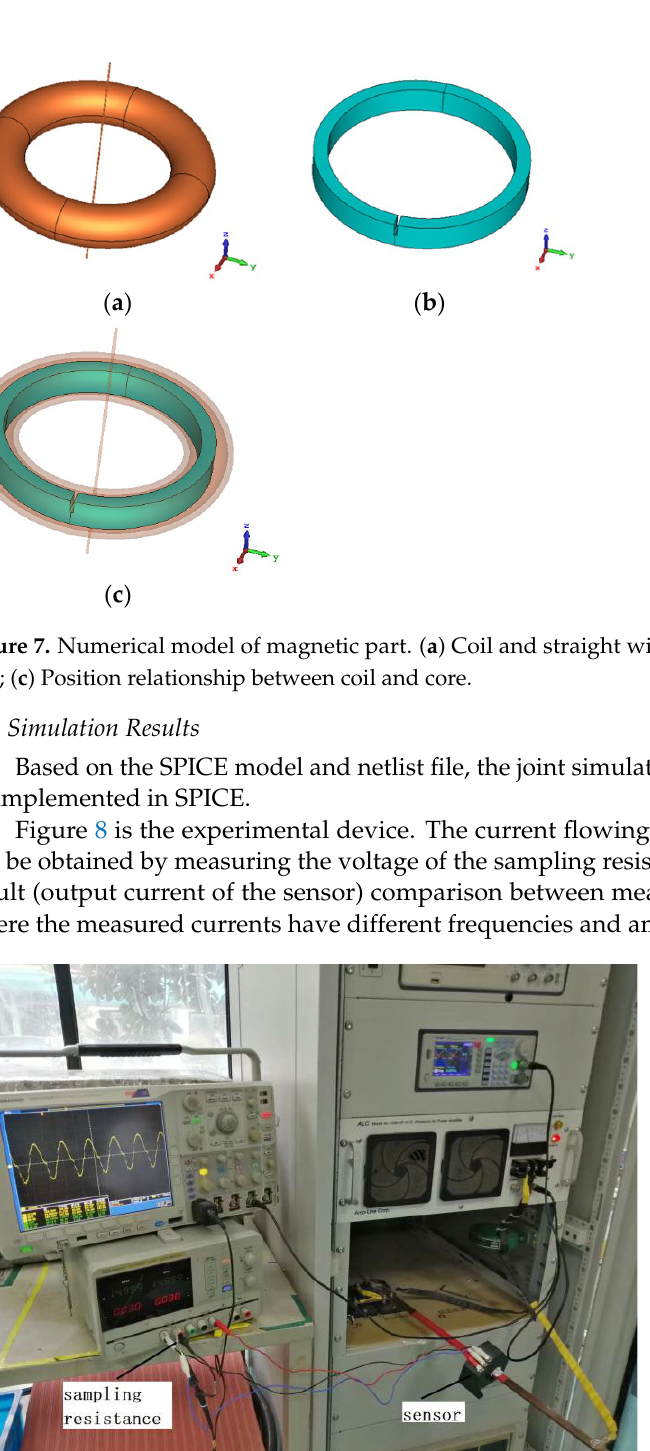
Figure 6. Circuit schematic for sensor.